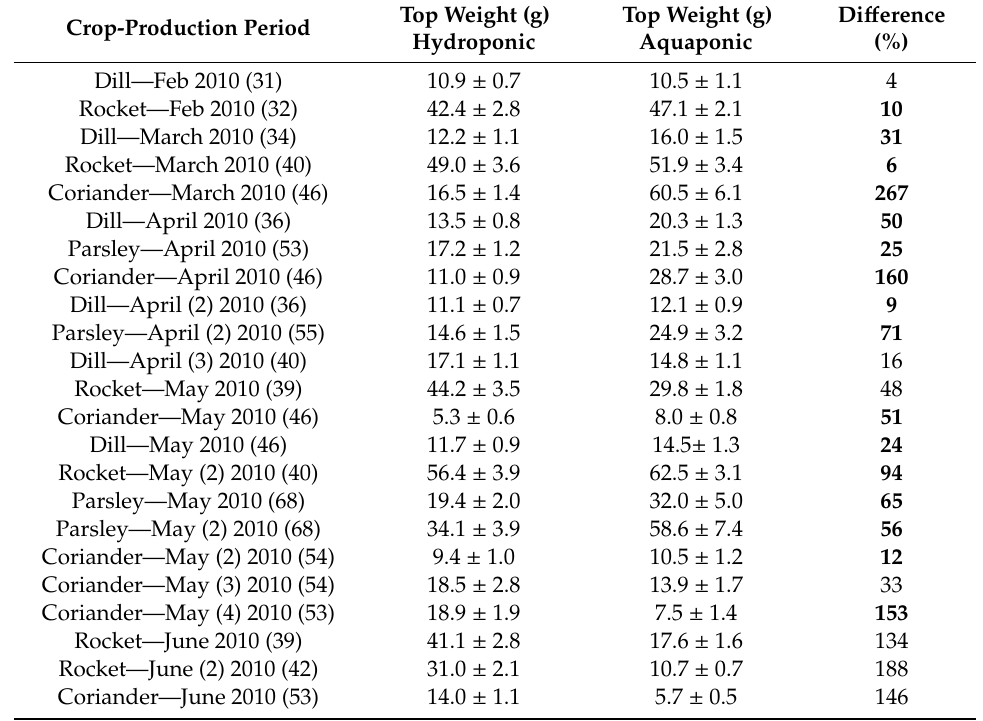
Table 7. Hydroponic vs. aquaponic NFT herb production comparisons—2010. The results include the mean leaf fresh weight (top weight) gain ± standard error of each herb and production period in each system, and the percentage di ff erence between the two systems for species and date. The di ff erences in the bold font indicate that the aquaponics system mean was larger than the hydroponic system mean. Bracketed numbers in the “crop production period” column represent the number of days in culture, from the day of seeding to